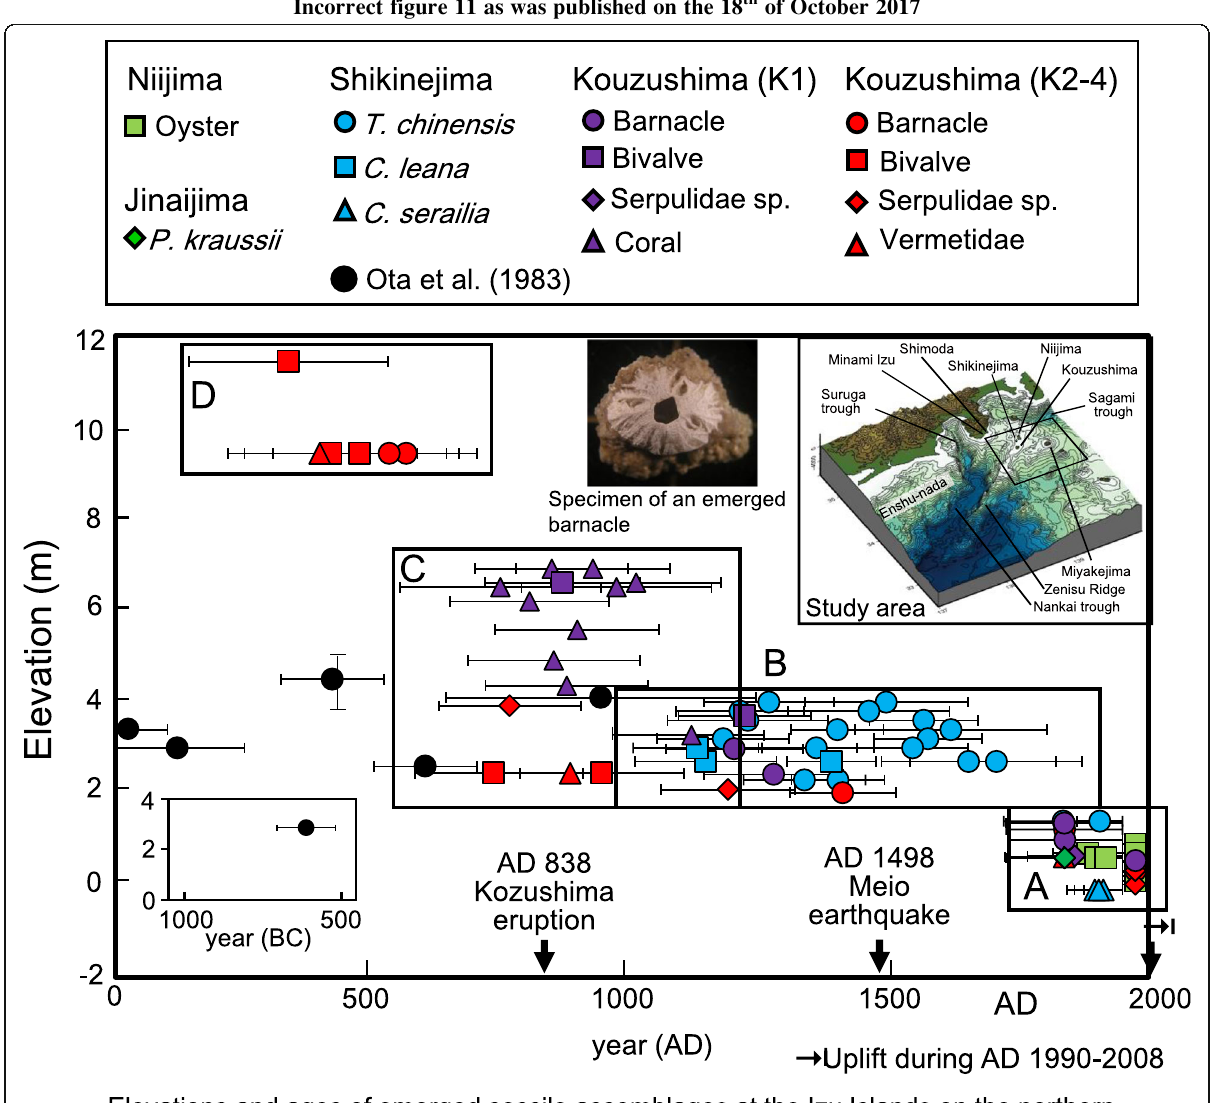
Incorrect figure 11 as was published on the 18 th of October